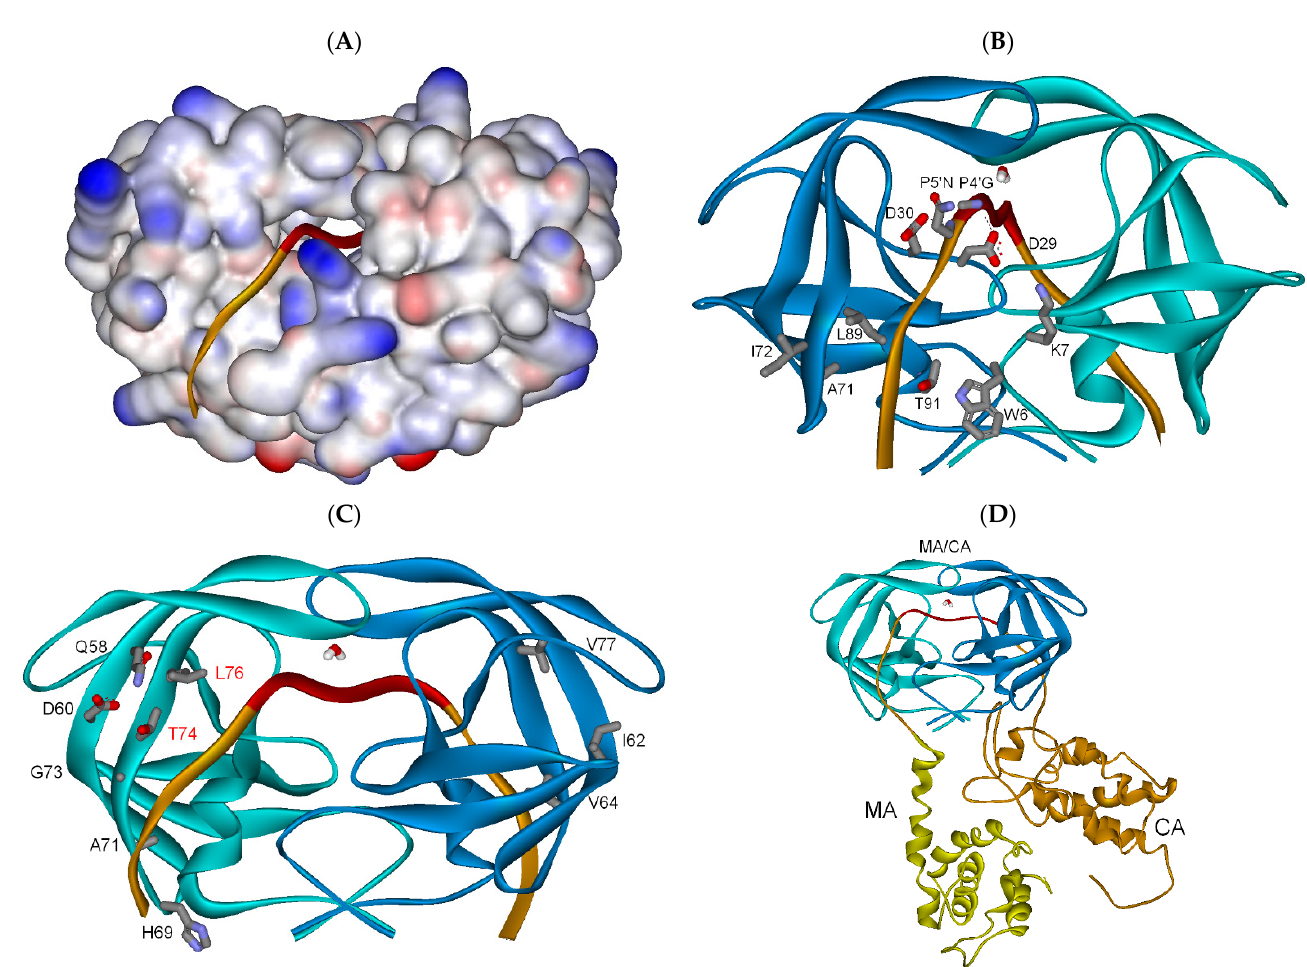
Figure 1. ( A ) HIV-1 PR (1KJ7.pdb as modified [22]) bound to 24-mer SP1-NC substrate (backbone ribbon), PR with electrostatic surface potential (blue positive, red negative), cleavage site residues P4-P4 ′ (red) bound to active site, cleavage site residues P12-P5/P5 ′ -P12 ′ (|P12-P5|) bound in S-grooves (bronze); ( B ) PR bound to 24-mer substrate as in ( A ), PR as backbone ribbon (A-subunit teal, B-subunit blue), seven S-groove residues that interacted with Gag cleavage site residues |P12-P5|in a NMR study by Deshmukh et al. [24] are shown in addition to D29 (carbon grey, oxygen red, nitrogen blue), SP1-NC cleavage site residues P5 ′ N and P4 ′ G including backbone nitrogens indicated, active site tetrahedrally coordinated water under flaps; ( C ) PR bound to 24-mer SP1-NC substrate as in ( B ), with ten native PR S-groove residues shown, Wensing and coworkers reported PI resistance mutations for each of those ten native residues [13], S-groove residues on PR A-subunit anti-parallel β -sheet (left), residues on backside of PR B-subunit S-groove anti-parallel β -sheet (right), red residue labels indicate primary PI resistance, black residue labels indicate secondary PI resistance, when residues were mutated as reported by Wensing and coworkers [13]; ( D ) PR bound to MA/CA cleavage site when part of a MA-CA polyprotein (1L6N.pdb as modified [23]) with backbone ribbon (MA yellow, CA bronze) as previously reported [23].